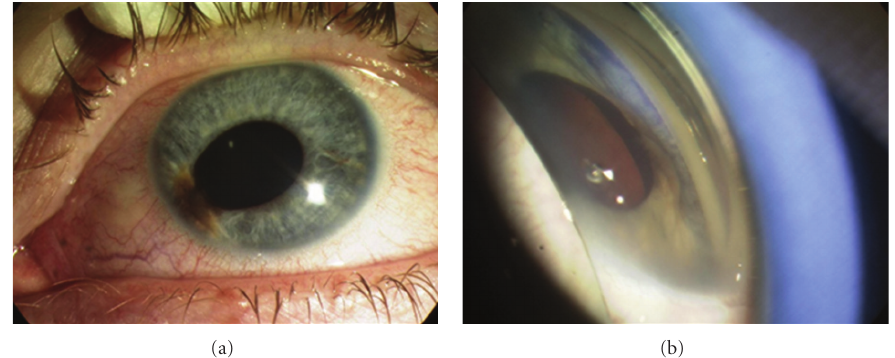
Figure 2: Iris melanoma located in the inferonasal portion of the right eye. Of note the associated corectopia and an episcleral sentinel vessel were adjacent to the lesion. This lesion extended to the anterior chamber and acquired a ring configuration as shown in gonioscopy.